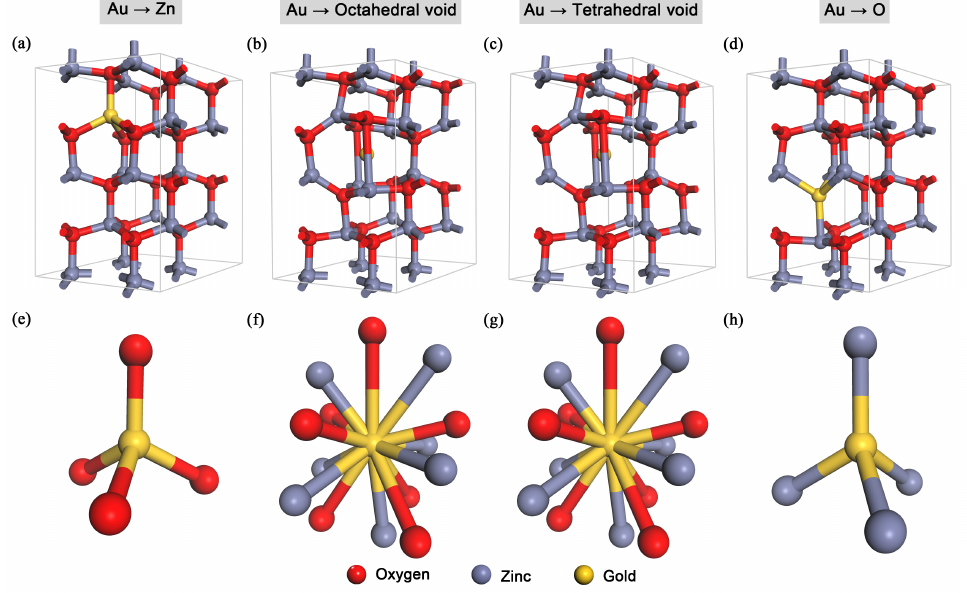
Figure 2. ( a – d ) The 2 × 2 × 2-supercell structural models of Au:ZnO with the gold ion in ( a ) the substitutional position of zinc, ( b ) the interstitial position of the octahedral void, ( c ) the interstitial position of the tetrahedral void, ( d ) the substitutional position of oxygen; ( e – h ) the vicinity and coordination of Au after the geometry optimization for the respective Au positions in the ZnO